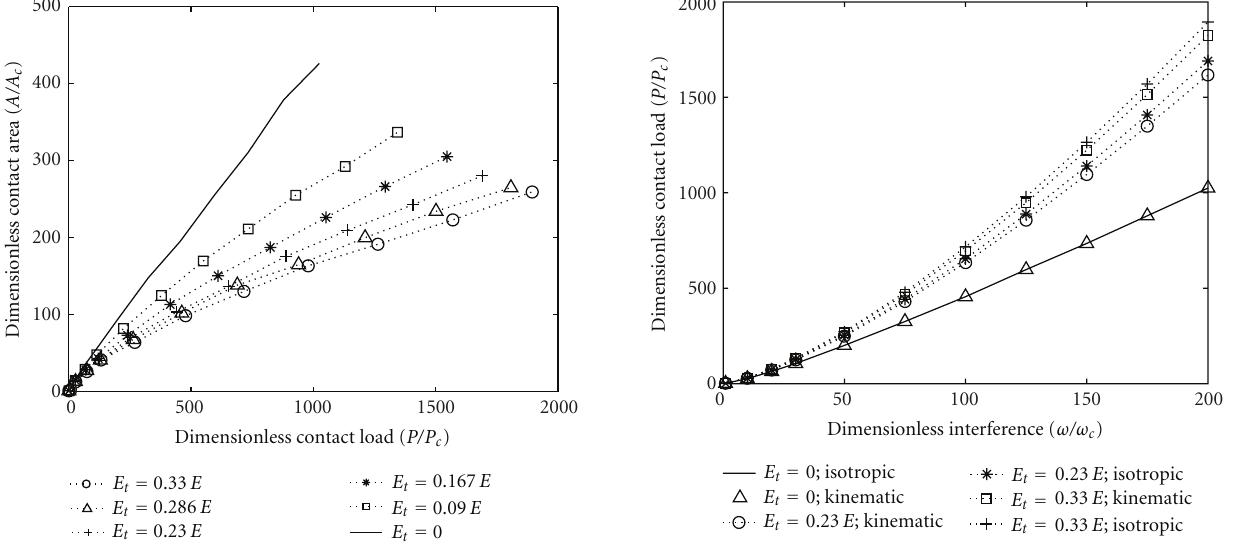
Figure 7: Dimensionless contact load versus dimensionless contact area for stick contact condition.